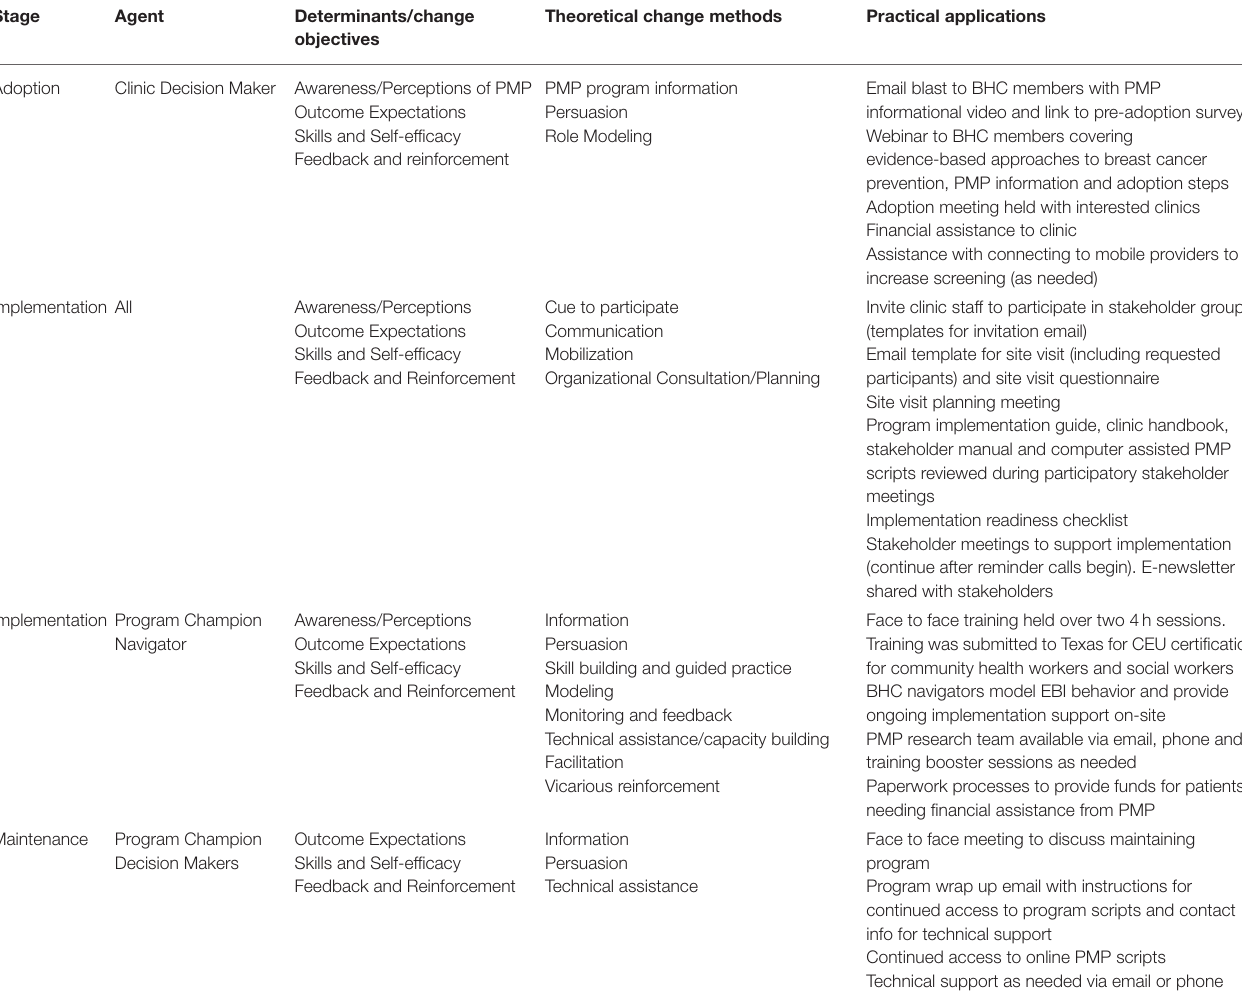
TABLE 4 | Peace of mind program implementation intervention